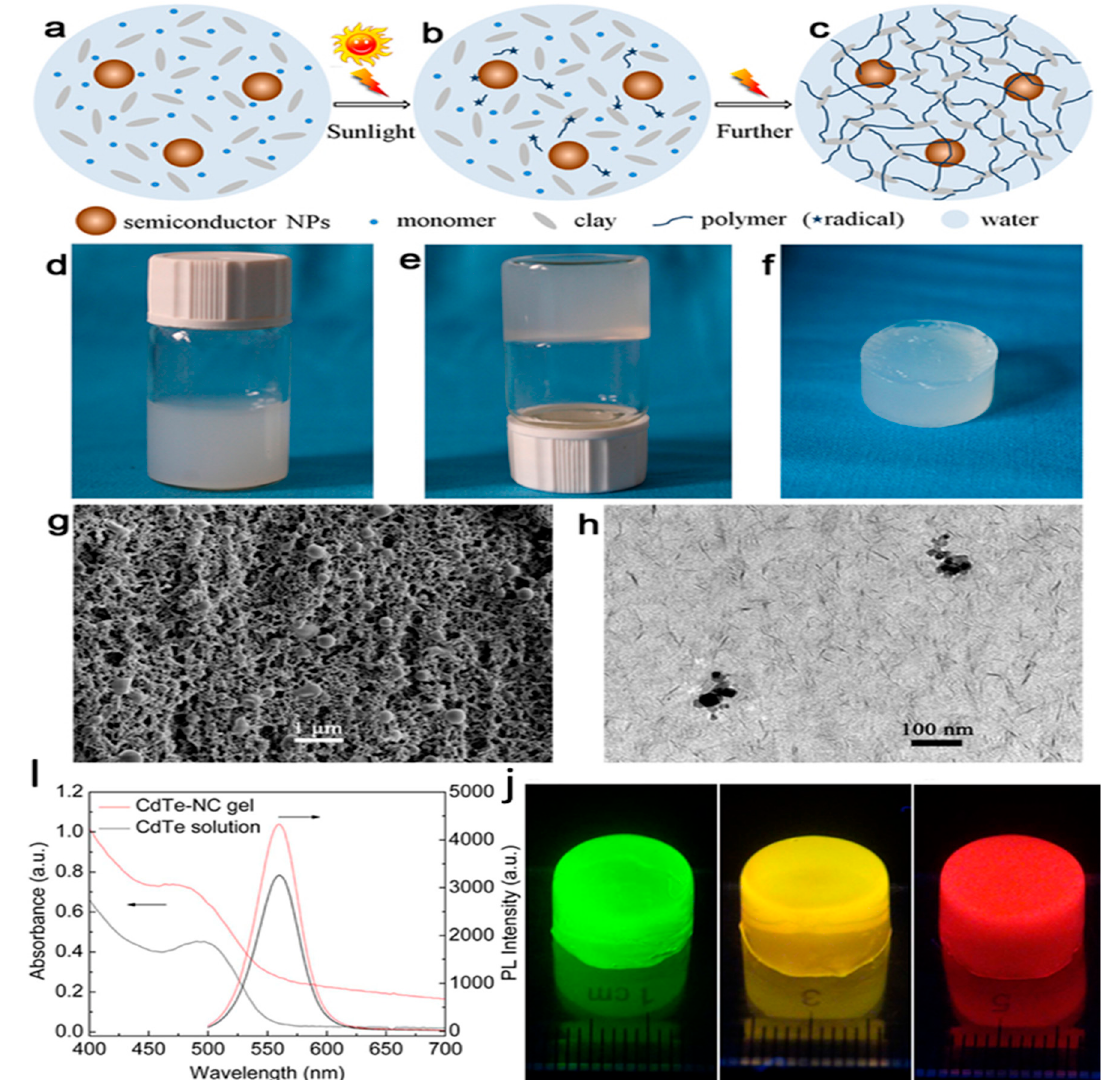
Figure 8. Proposed mechanism ( a – c ), photographs ( d – f ), and SEM image ( g ) and